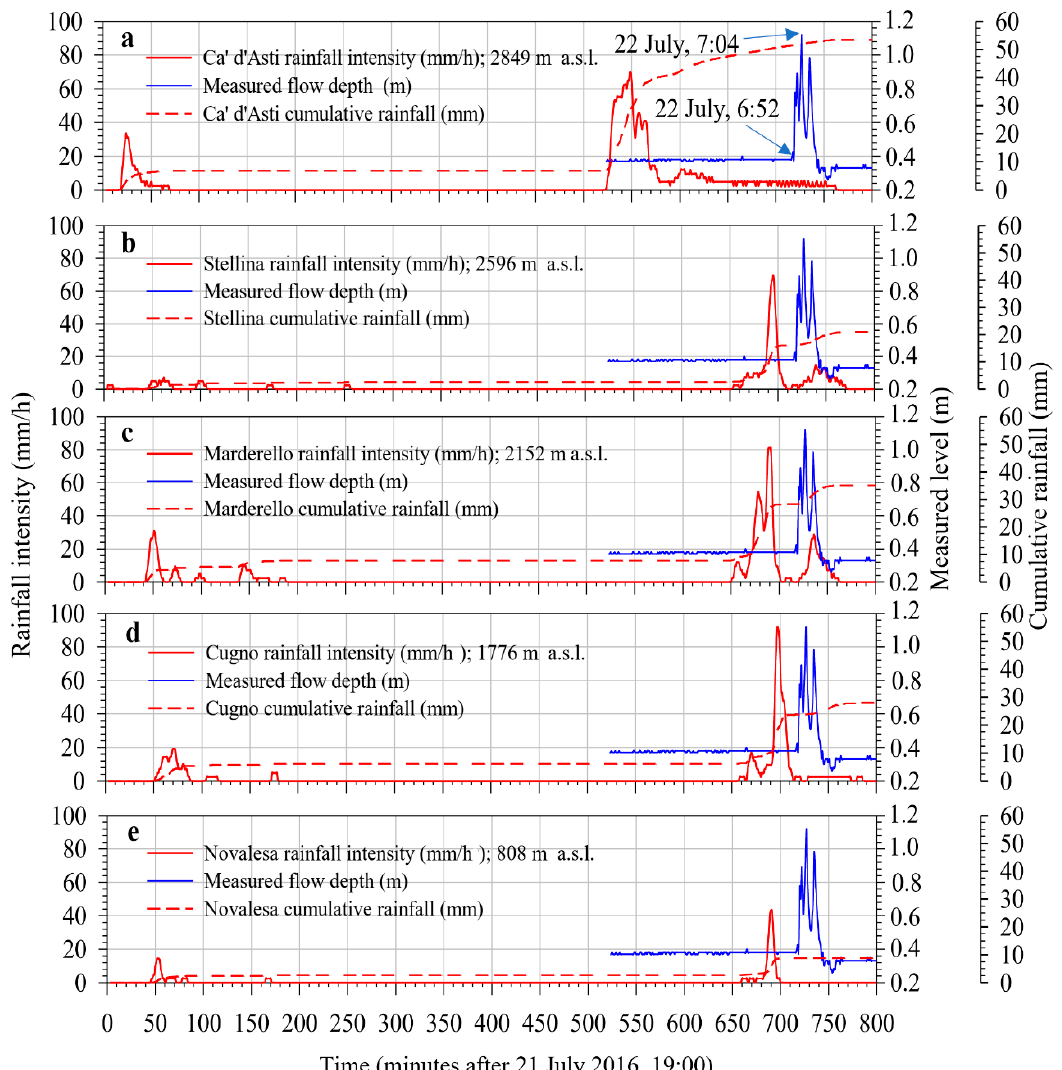
Figure 2. Rainfall time histories, measured flow depth and cumulative rainfall of the available five pluviometers, from 21 July 2016, 19:00 to 22 July, 8:50; ( a ): Ca’ d’Asti 2849 m a.s.l.; ( b ) Rifugio Stellina 2596 m a.s.l.; ( c ) Pian Marderello 2152 m a.s.l.; ( d ) Cugno 1776 m a.s.l.; ( e ) Novalesa 808 m a.s.l.